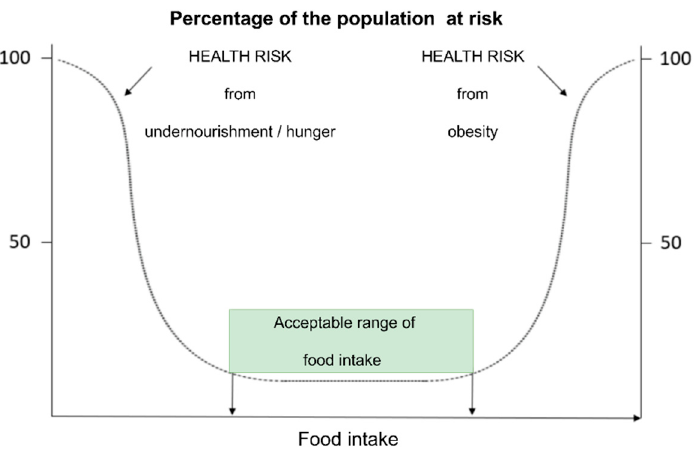
Figure 1. Risk of under- and overconsumption of food (Source: Adopted from European Food Safety Authority (EFSA) Statement [19]).